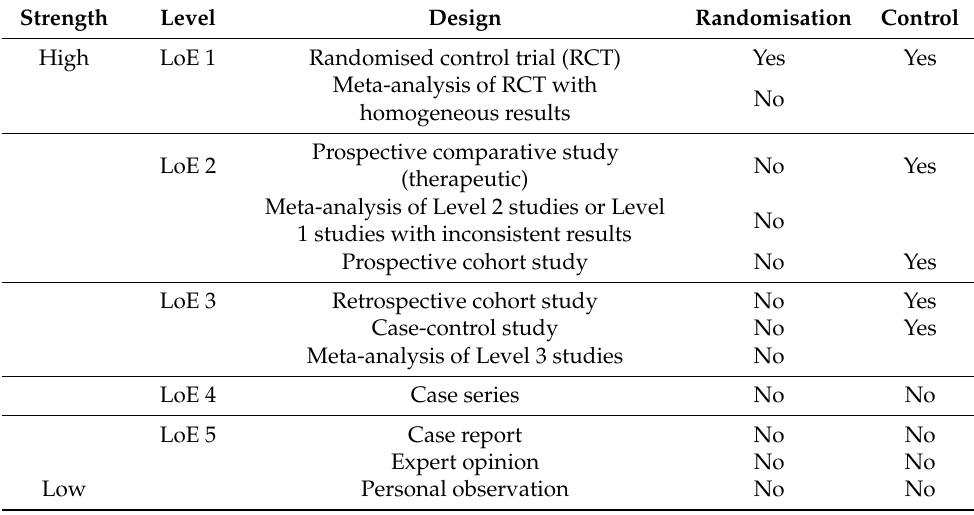
Table 1. Levels of evidence (LoE) are categorised and reported as adapted from https://www. hydroassoc.org/research-101-levels-of-evidence-in-hydrocephalus-clinical-research-studies/ (accessed on 22 September